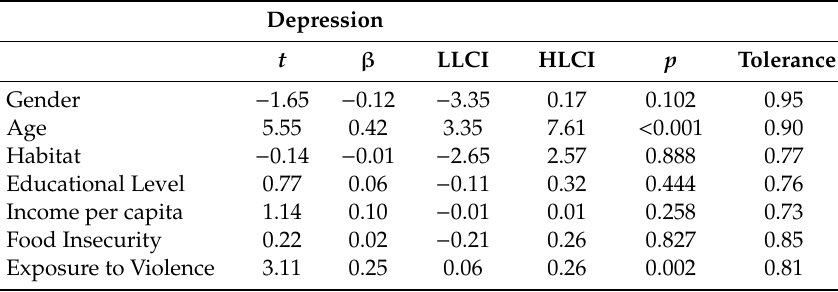
Table 4. Hierarchical regression analysis for depression.